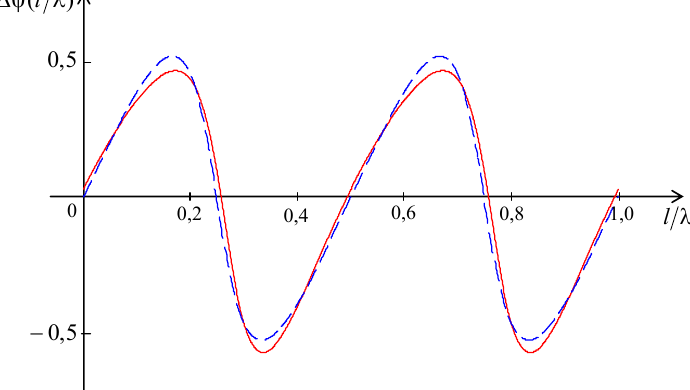
Fig. 2. The nature of the effect of the non-ideal probe on the phase distribution of the electromagnetic wave in the transmission